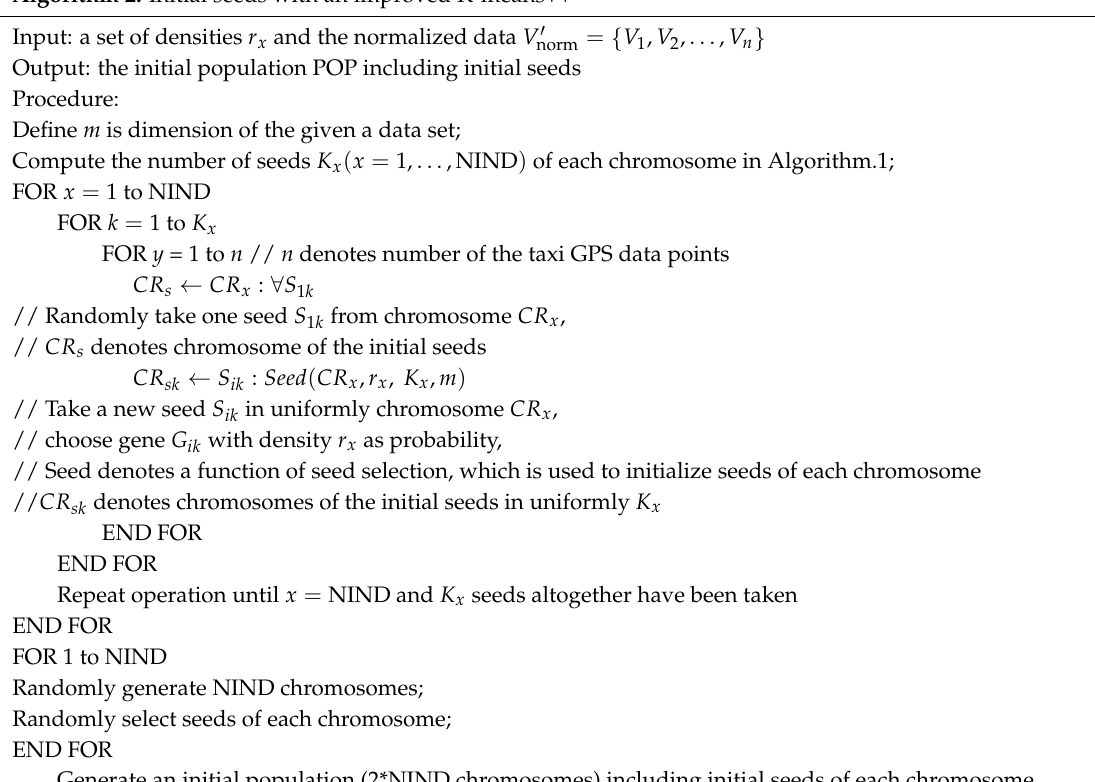
Algorithm 2. Initial seeds with an improved